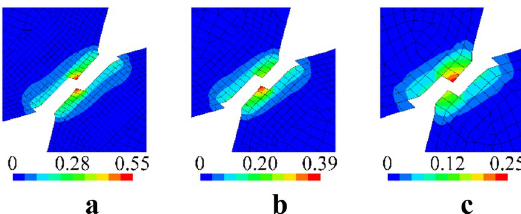
Figure 7 Equivalent plastic strain nephograms at fracture for N–45 specimen using the model r